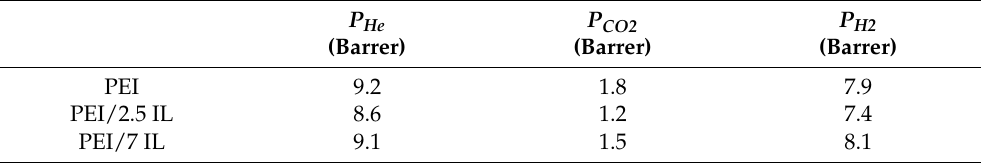
Table 2. Gas permeability coefficients of PEI/IL membranes (the uncertainty was better than 5% for P ).